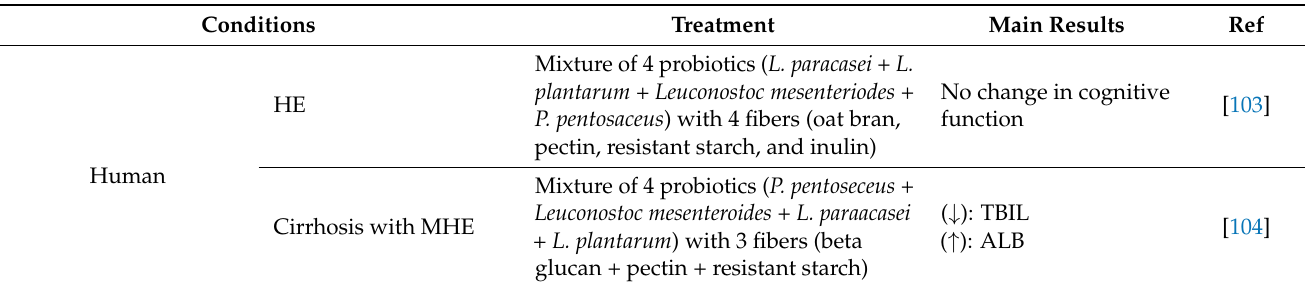
Table 4. Human studies using